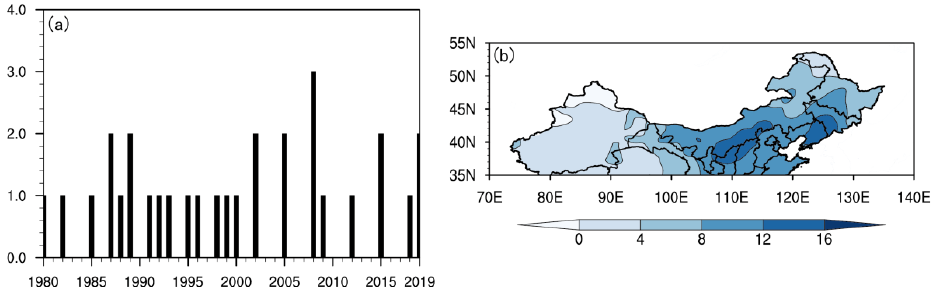
Figure 2. ( a ) Frequency of RSCEs in the winter of northern China from 1980 to 2019 (unit: number of occurrences) and ( b ) spatial distribution of cooling amplitude averaged by 30 RSCEs (unit: °C).